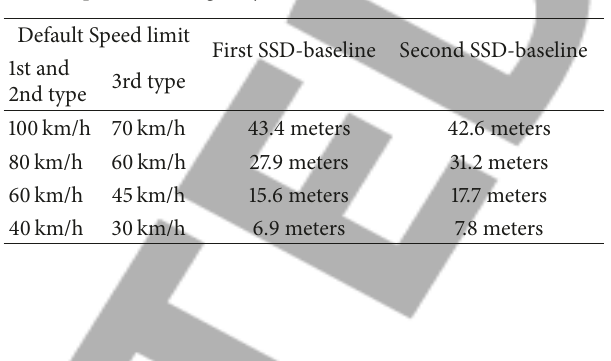
Table 2: The values of SSD-baselines according to the current Default speed of the highway